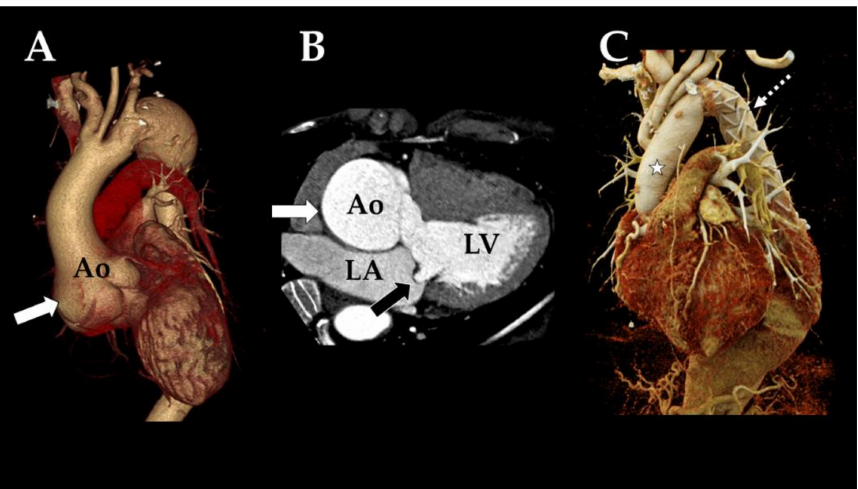
Figure 1. Thoracic aorta CTA findings in Marfan syndrome patients: The 3D volume rendering technique image ( A ) and three-chamber view image ( B ) showed dilated aortic root in tulip bulb configuration and annuloaortic ectasia (white arrow). Mitral valve prolapse is demonstrated ( B : black arrow). The post-operative CTA image demonstrated the normal size of the vascular graft at ascending thoracic aorta ( C : star) and evidence of thoracic endovascular aortic repair ( C : dashed arrow). (Ao; aorta, LA; left atrium, LV; left